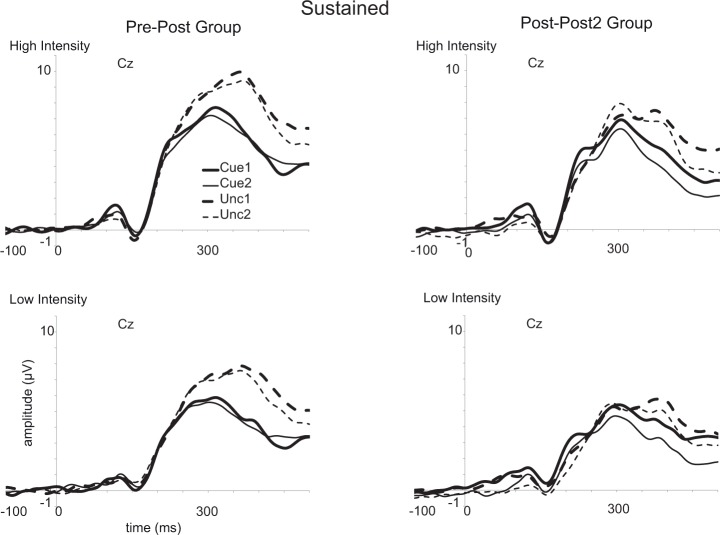
Event-related potentials (ERPs) evoked by the intracutaneous electrical stimuli at the vertex (Cz).Results are shown for the sustained spatial attention condition. Averages are shown for cued stimuli in the first and the second session (Cue1 and Cue2) and for uncued stimuli in both sessions (Unc1 and Unc2). Results for high intensity stimuli are displayed in the upper row while results for the low intensity stimuli are presented in the lower row. Results for the pre-post group are presented in the left panel, while results for the post-post2 group are presented in the right panel.